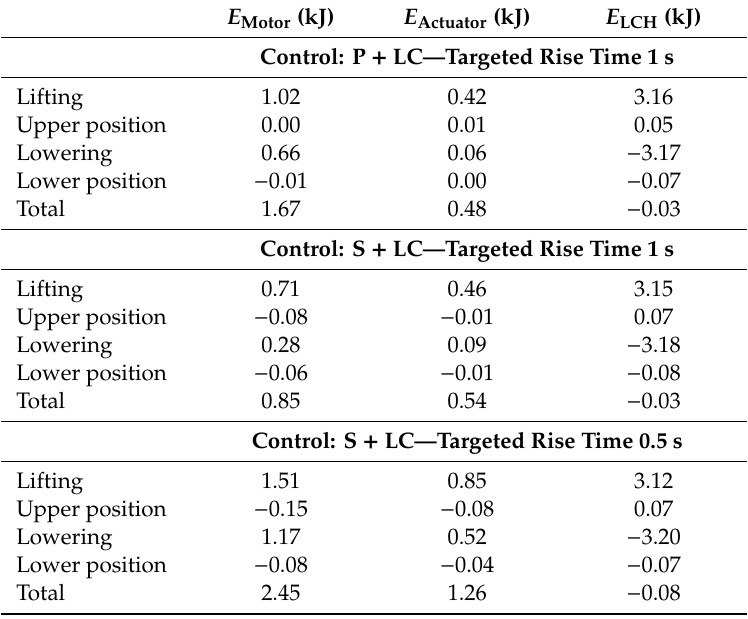
Table 5. Energy consumption during the di ff erent phases of one motion